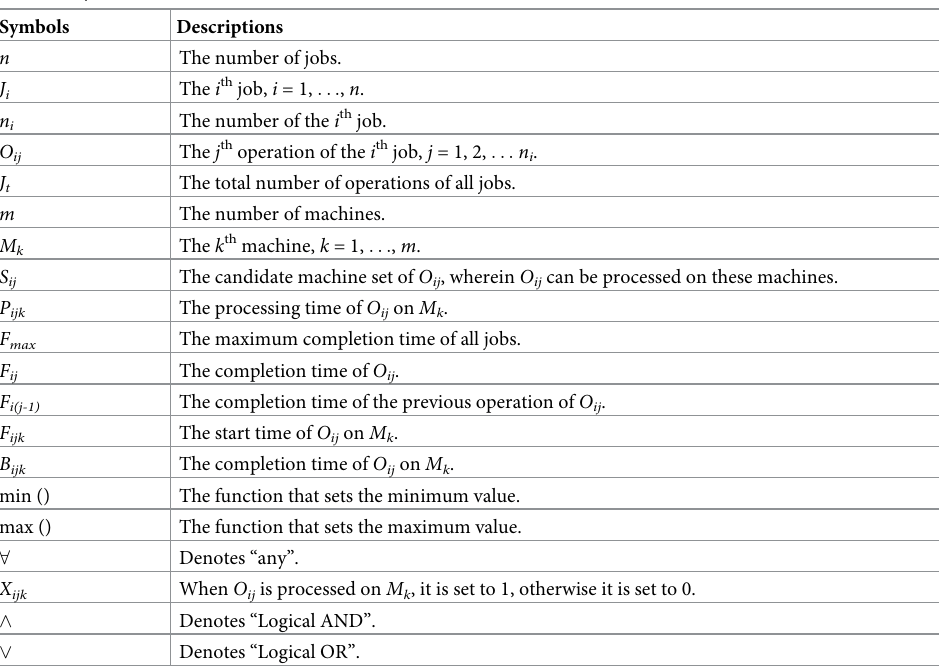
Table 2. Symbols of